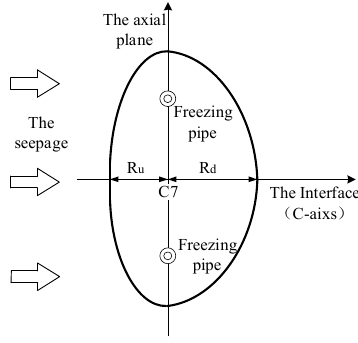
Figure 12. The positions of R u and R d .